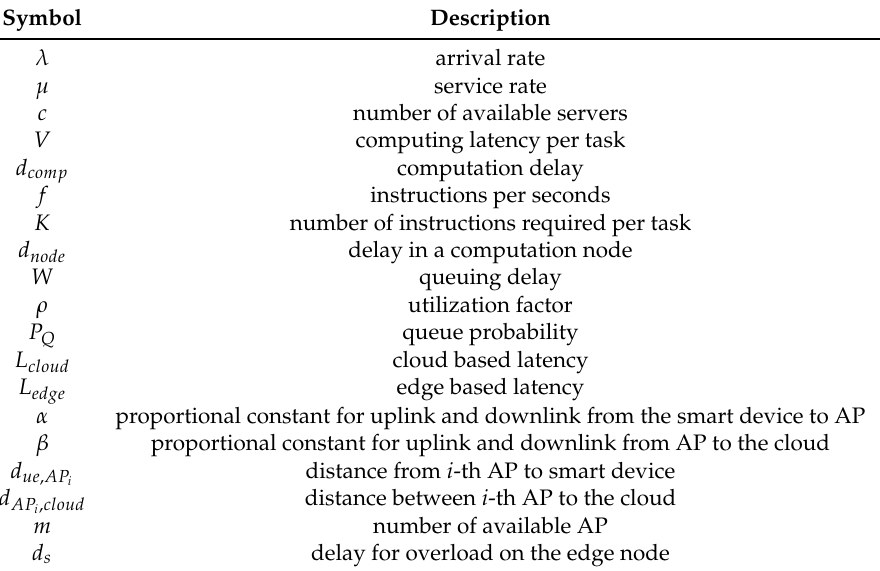
Table 1. Symbols in the mathematical